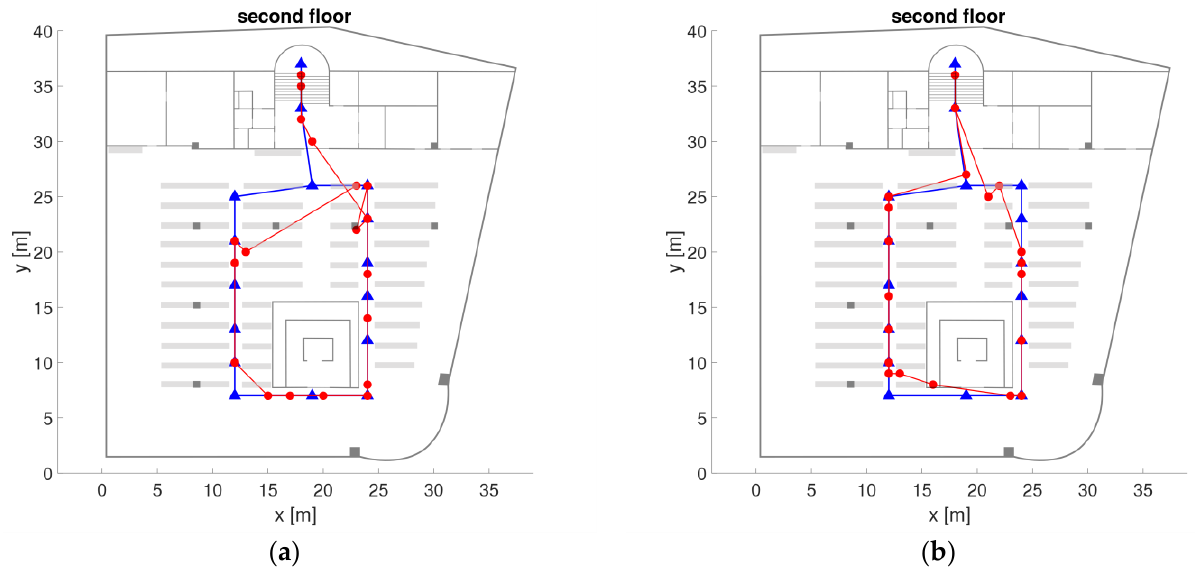
Figure 18. Trajectories of two measurement runs on the second floor with estimated positions in red and ground truth in blue. ( a ) worst result; ( b ) good result.